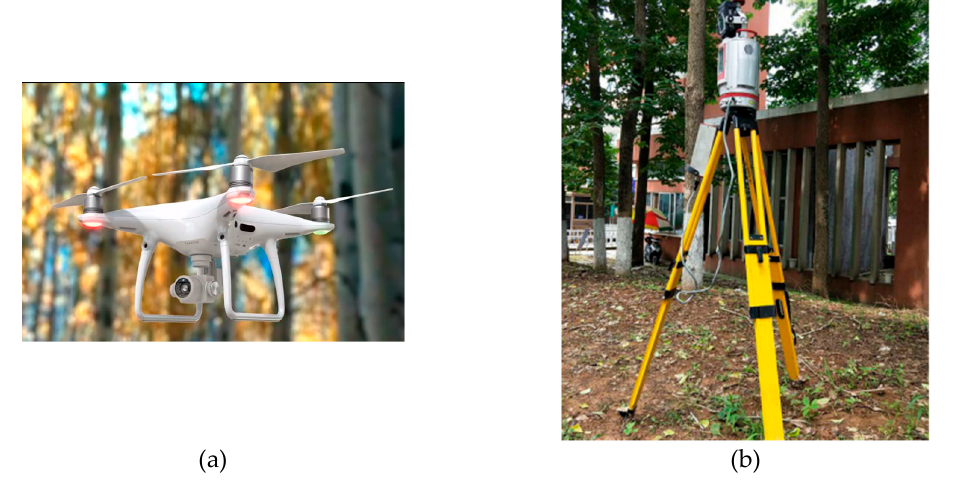
Figure 3. ( a ) DJI Phantom 4 Pro and ( b ) Riegl VZ-400i terrestrial laser scanning.